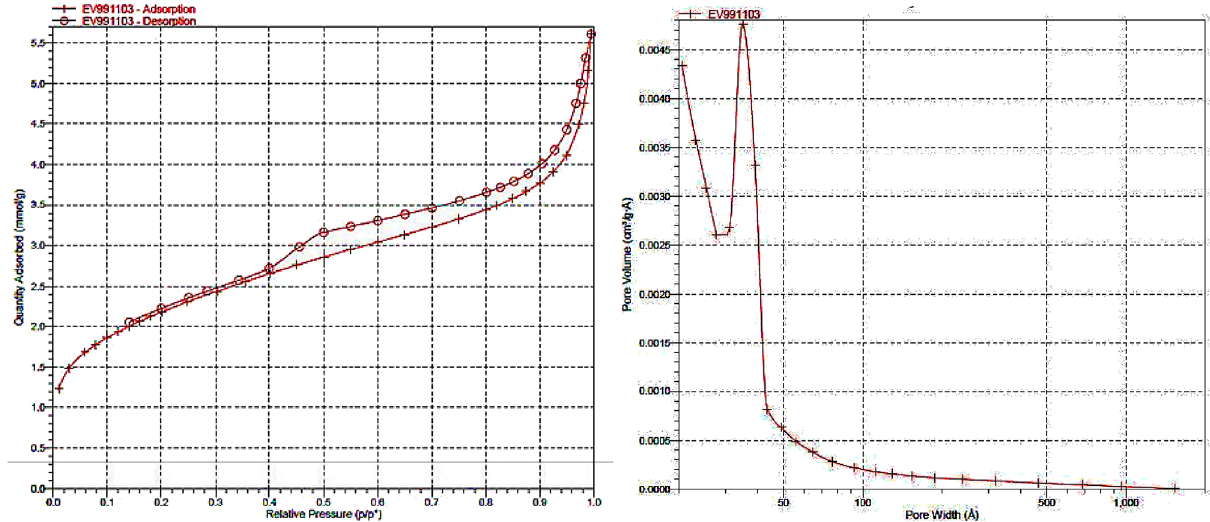
Figure 7. N 2 adsorption–desorption isotherm of the Cu@APS-TDU-PMO mesoporous material ( 1 ).